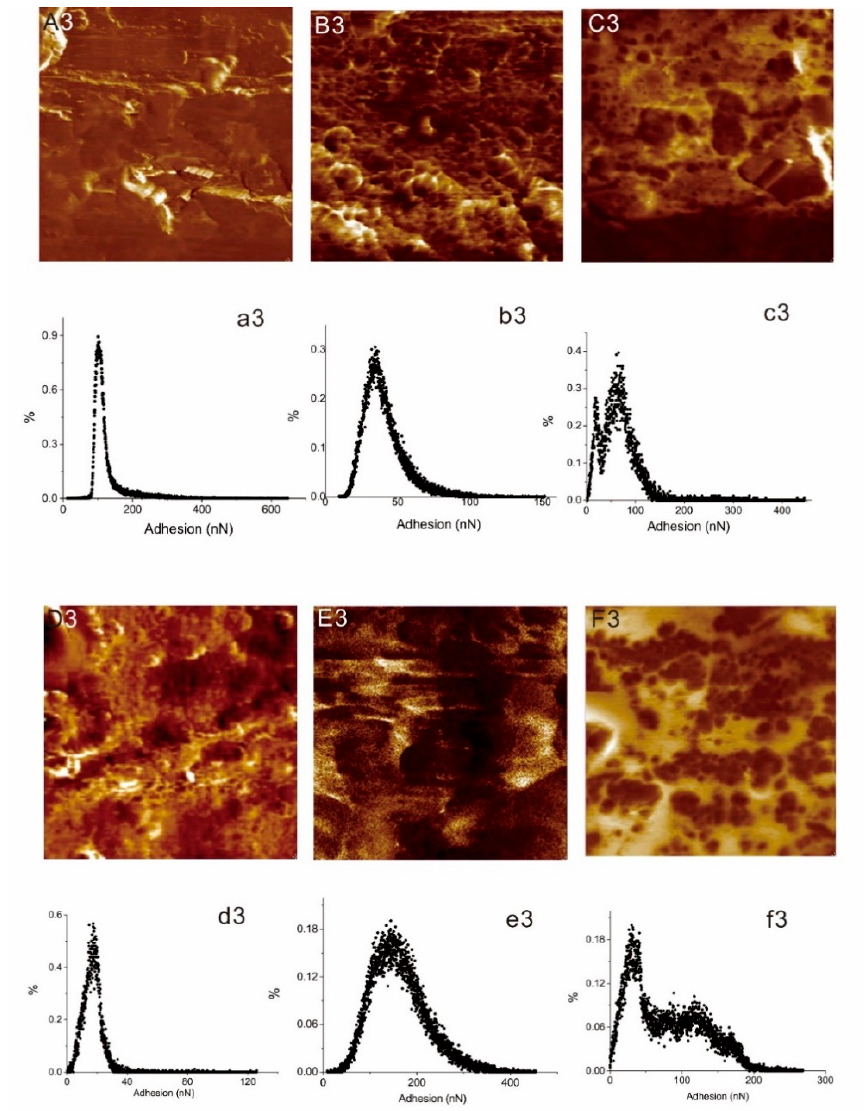
Figure 6. AFM adhesion maps of a 3 × 3 μ m 2 region, and the adhesion force distribution graphs of ( A3, a3 ) untreated Al alloy; ( B3, b3 ) MP; ( C3, c3 ) MPAL; ( D3, d3 ) MPALSi; ( E3, e3 ) P2; ( F3, f3 ) P2Si.